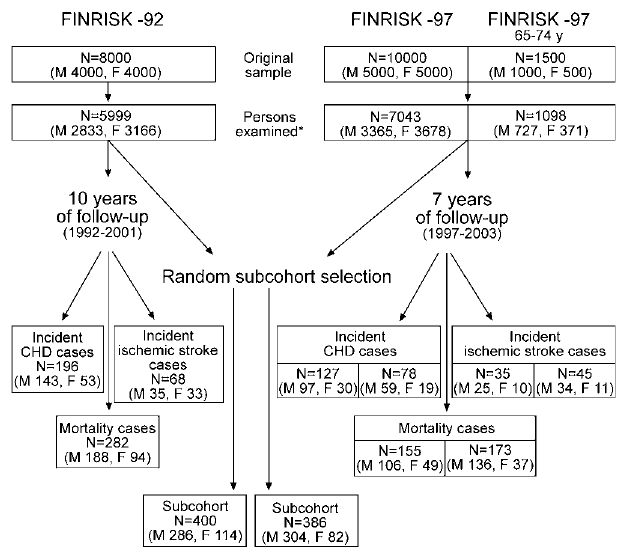
Figure 1. A Description of the FINRISK 1992 and 1997 Cohorts Compared to FINRISK-92, the FINRISK-97 cohort includes an additional sample of individuals aged 65–74 y. Numbers for this additional sample are described at the right-hand side for each endpoint. Persons examined refers to cohort individuals for whom information on smoking, blood pressure, cholesterol, and DNA, as well as consent for the use of DNA to study CHD and stroke, were available. Subcohorts are stratified random samples of the original cohorts including also cases. Mortality cases show total mortality, including also those who died from CHD or stroke. Thus, numbers in the boxes of subcohorts and outcome events are not mutually exclusive (see Table 1). F, females; M,